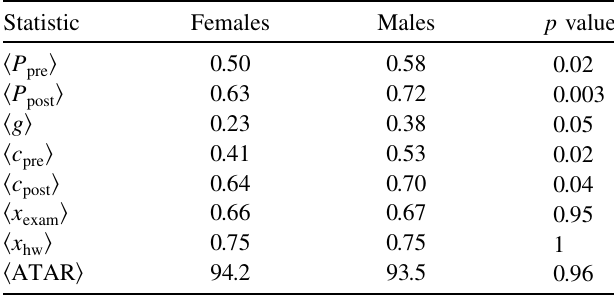
TABLE V. RCI statistics by gender for the Physics 2 class. h P